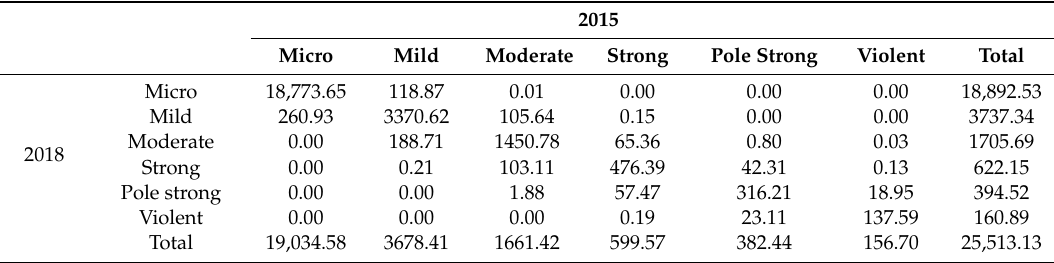
Table 8. The transfer matrix of soil erosion intensity grades in the Taohe River Basin from 2015 to 2018 (km 2